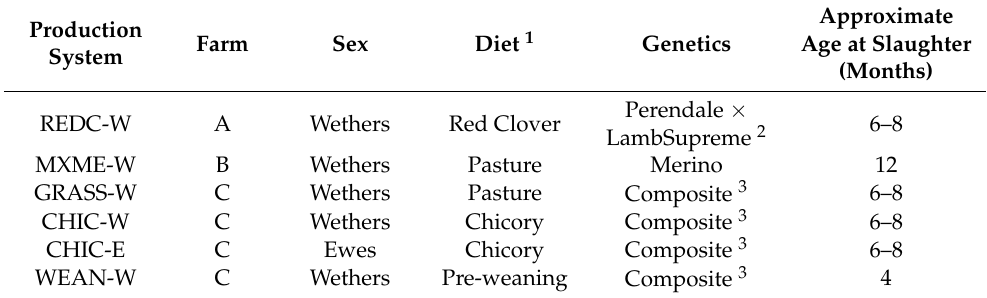
Table 1. Animal sex, diet, genetics, and age at slaughter for Farm A, B, and C ( n = 8 lambs per group).